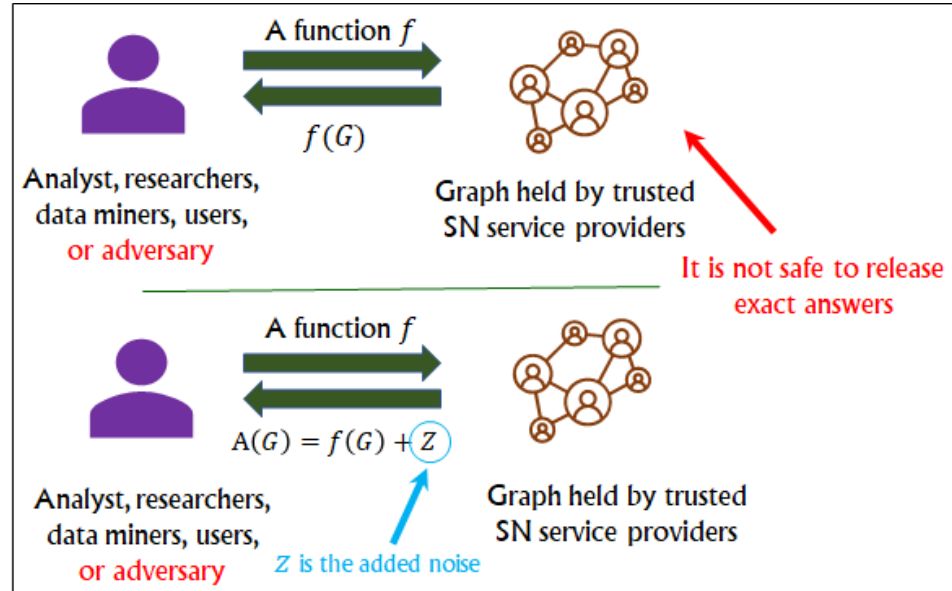
Figure 18. Overview of query output perturbation in DP